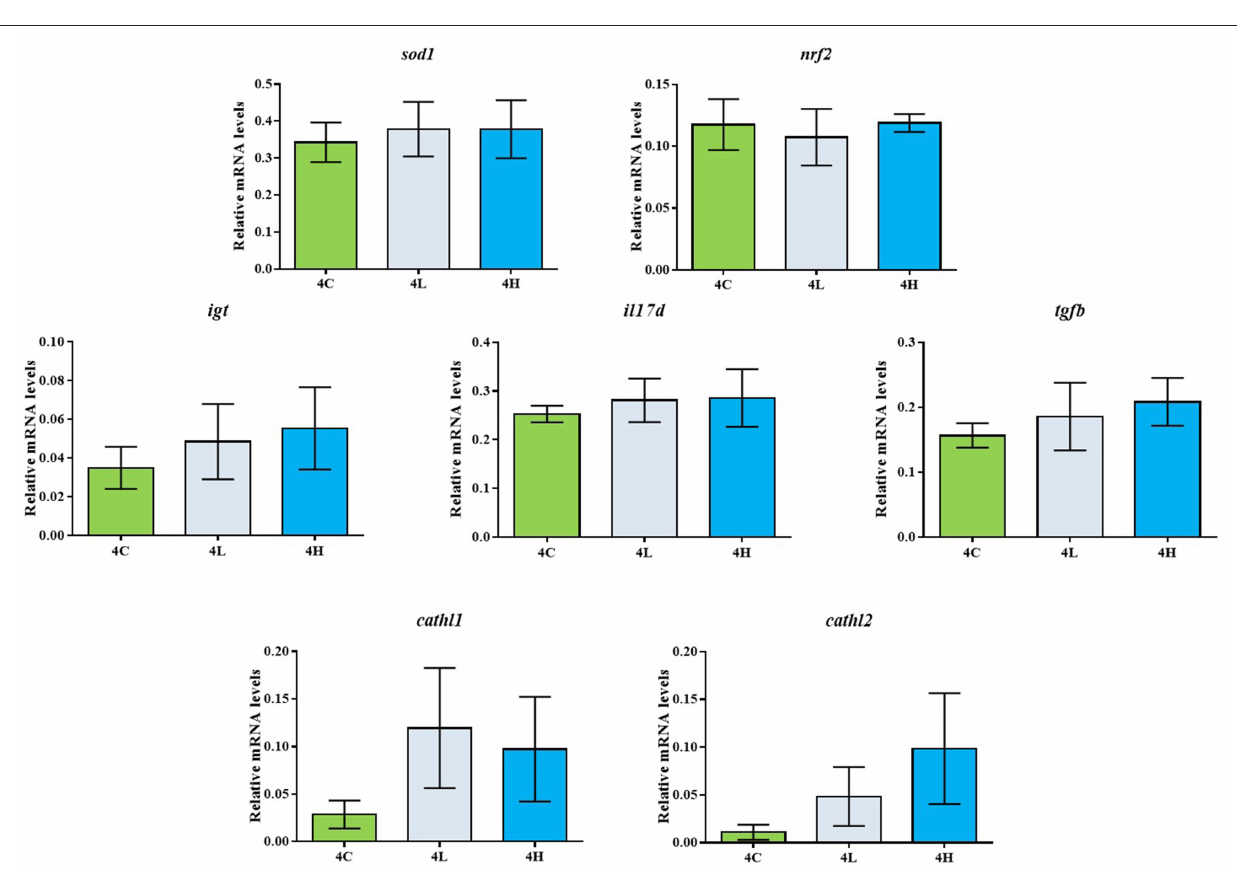
not detectable. The expression of cathl1 and cathl2 were higher in the alga-fed groups compared to the values of the control group ( Figure 3 ). However, a statistical significance was not